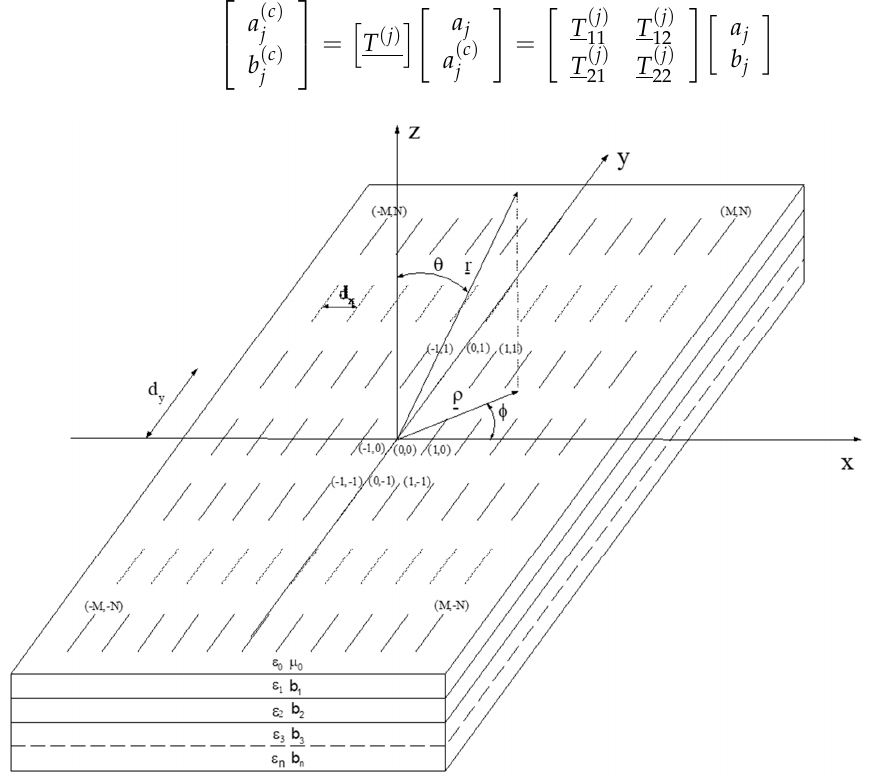
and matrix T connects the field on the “right a with the field on the “left”, upper side of the structure: